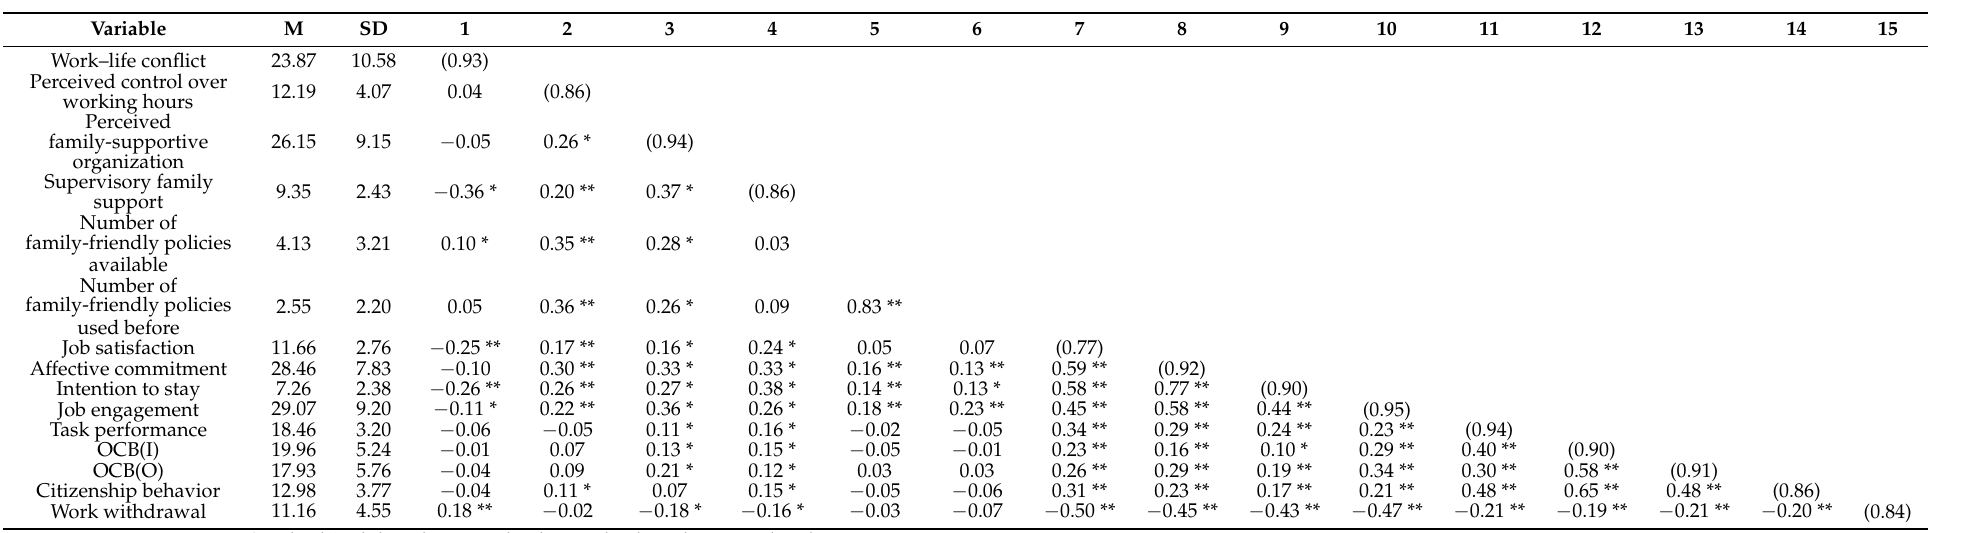
Table 1. Descriptive statistics and intercorrelations among study